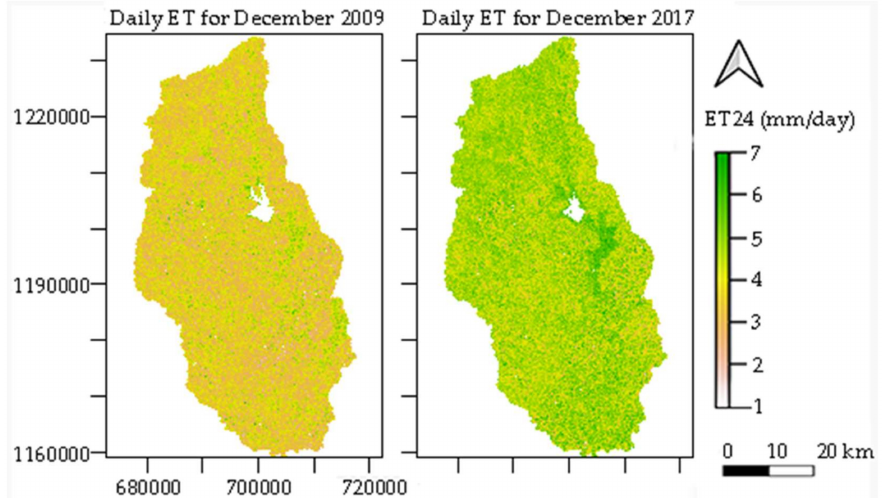
Figure 13. Maps of the daily evapotranspiration (ET) from ASTER images for December 2017 and December 2009 (WGS 84 UTM Zone